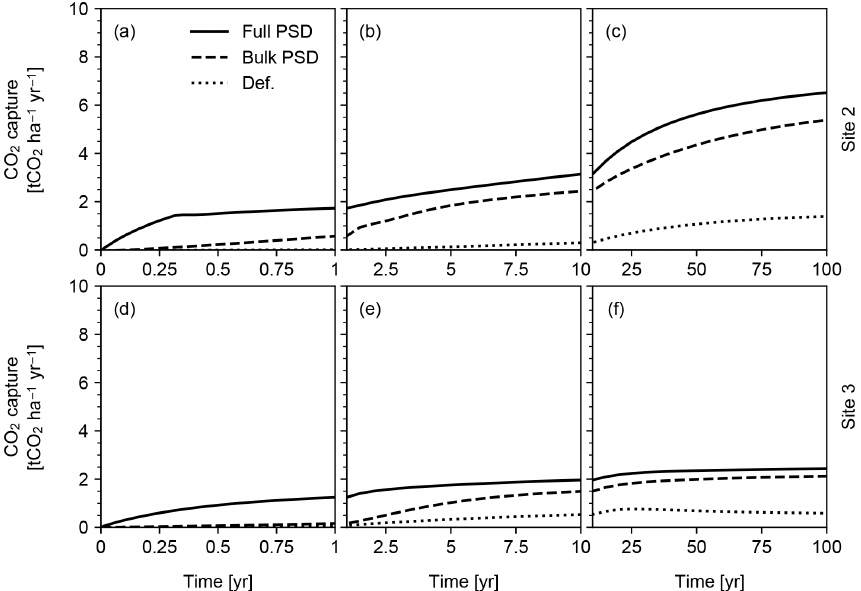
Figure 14. CO 2 capture predicted in simulations of continuous basalt powder application at Sites 2 and 3 in Table 8 with the surface area calculation based on the assumed hydraulic radius (“Def.”), tracked PSD for bulk soil (“Bulk PSD”) and tracked PSDs for individual solid species (“Full PSD”). See Sect. 3.2.2 for details.